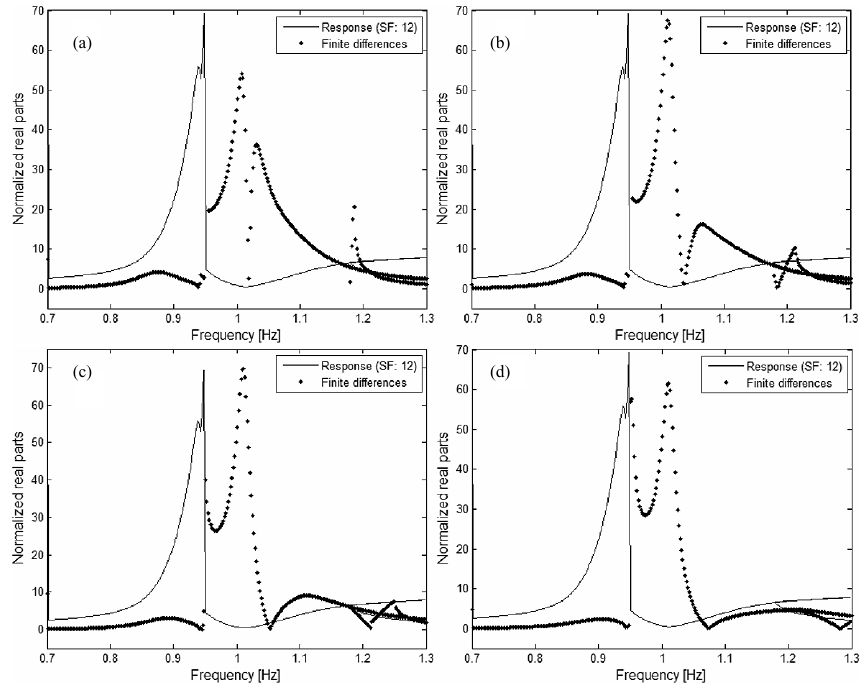
Fig. 8. Finite difference estimations of the Response H ( ω,p ) with respect to ρ : (a) ∆ ρ / ρ = 1%; (b) ∆ ρ / ρ = 5%; (c) ∆ ρ / ρ = 10%; (d) ∆ ρ / ρ =